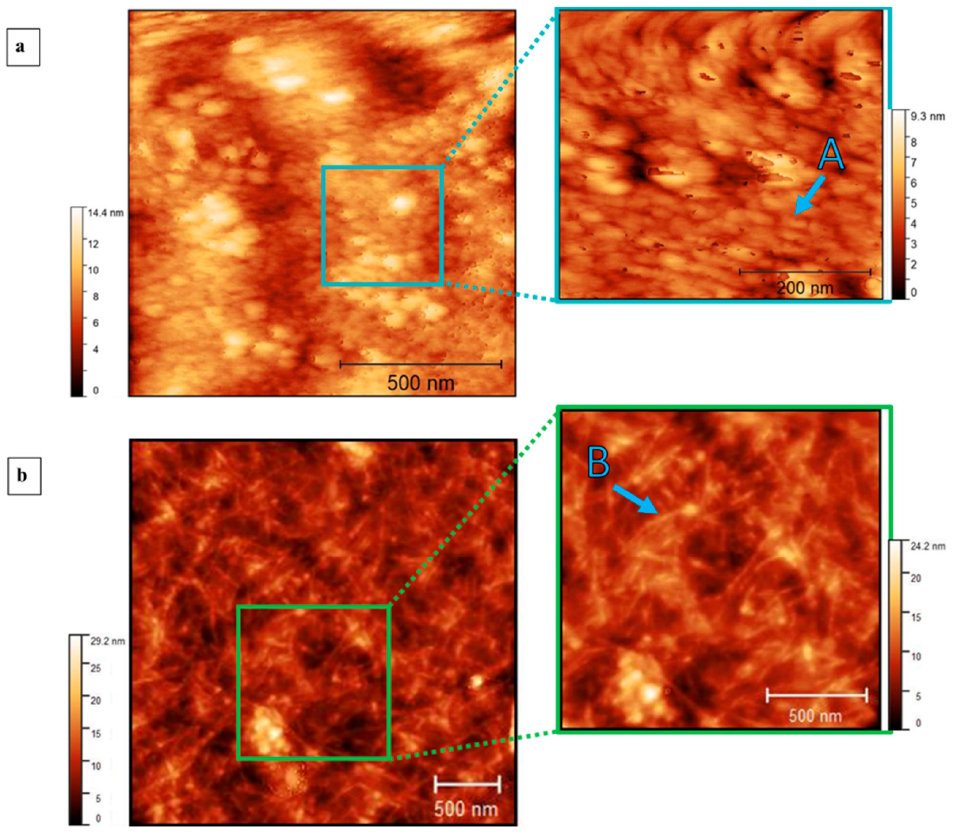
Figure 6. AFM images at different magnifications of keratin films obtained by drop-casting deposition, the color bar represents the variation of thickness of the materials on the substrate. ( a ) Images of keratin extracted from wool. Point A indicates the globular structure with a radius around 45 nm. ( b ) Images of keratin extracted from feathers. Point B indicates elongated structures that have lengths of approximately 500 nm.